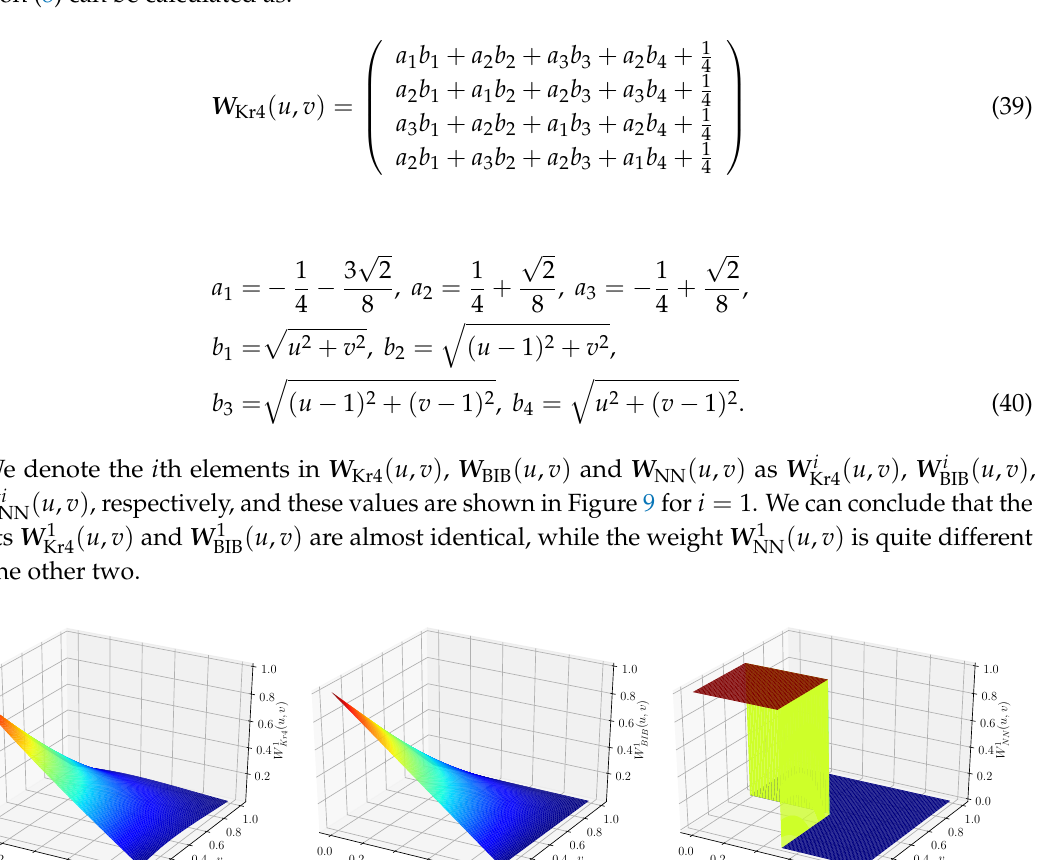
( u , v ) , W 1 ( u , v ) , and W 1 Kr4 BIB